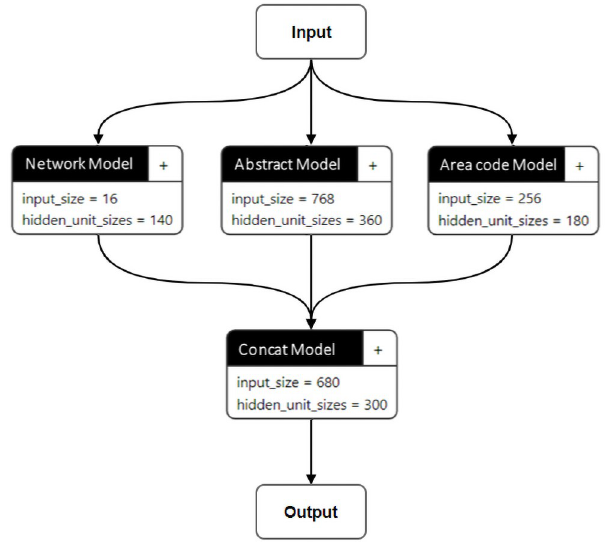
Fig 5. Optimal deep learning structure for prediction of future growth potential of technology